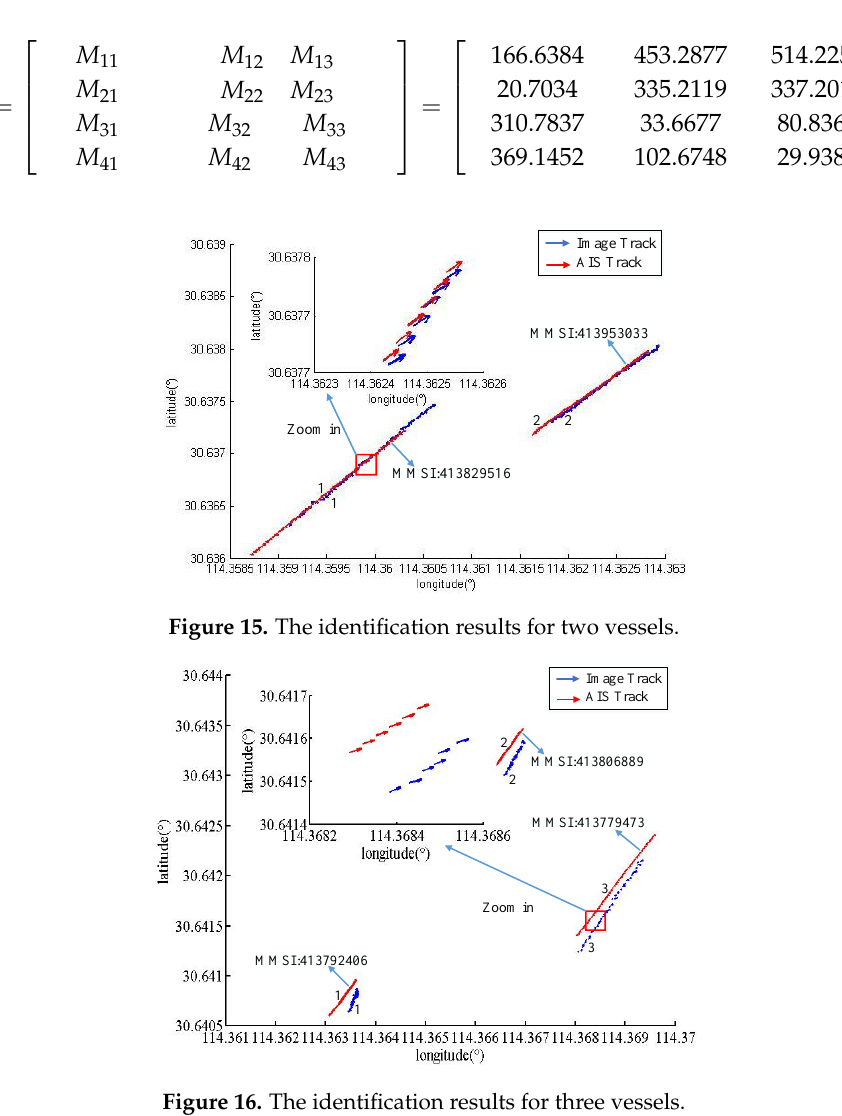
Figure 16. The identification results for three vessels.